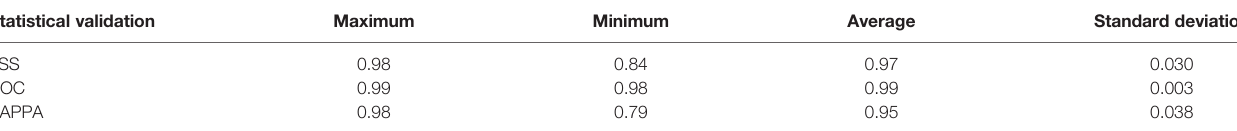
TABLE 3 | TSS, ROC, and KAPPA values for the ensemble